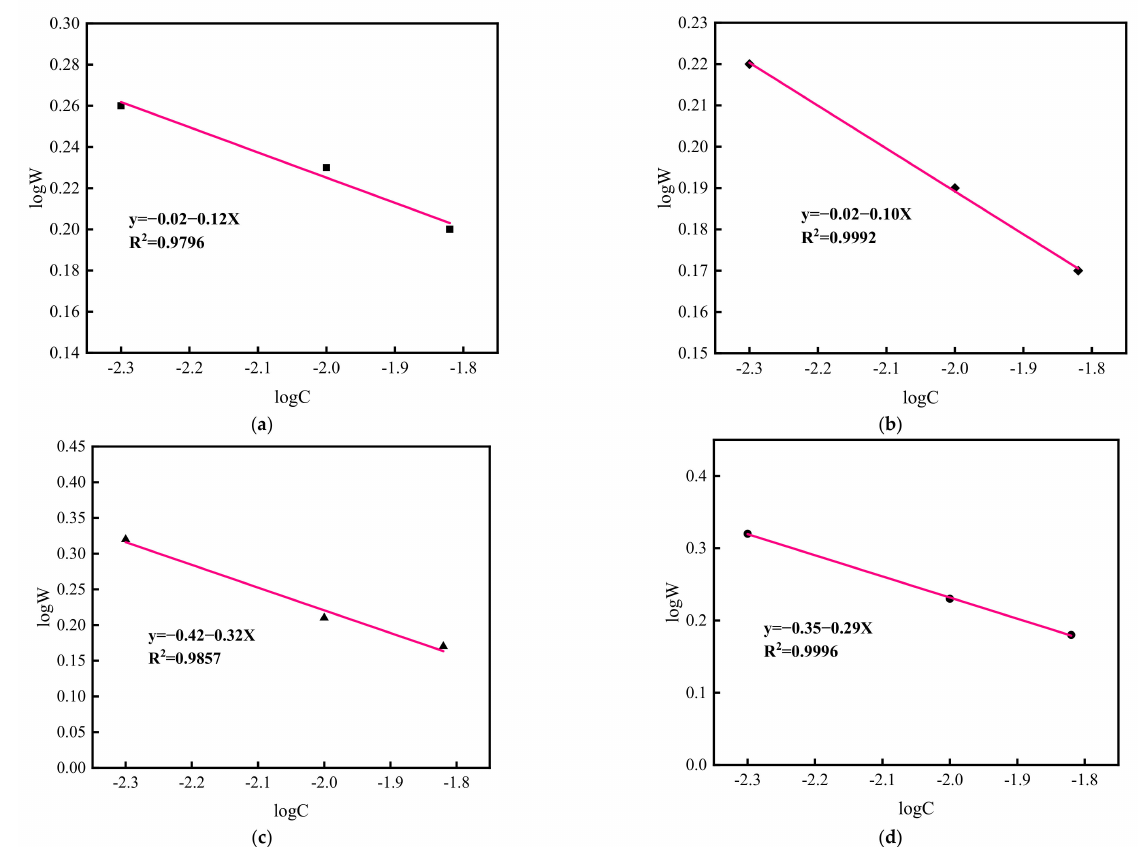
Figure 2. LogW–logC curve of different coagulants. ( a ) MgCl 2 , ( b ) CaCl 2 , ( c ) AlCl 3 , ( d ) FeCl 3 .